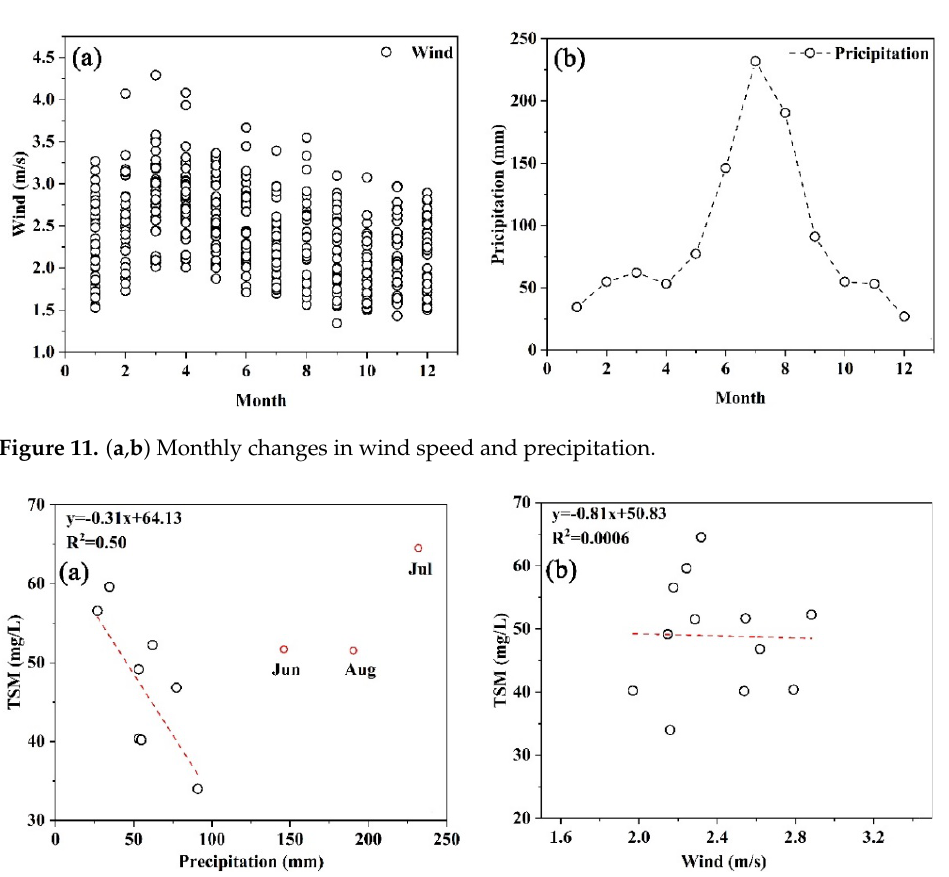
Figure 12. ( a ) Linear relationship between TSM and precipitation; ( b ) linear relationship between TSM and wind speed. Table 1. Flood times of the Huai River.